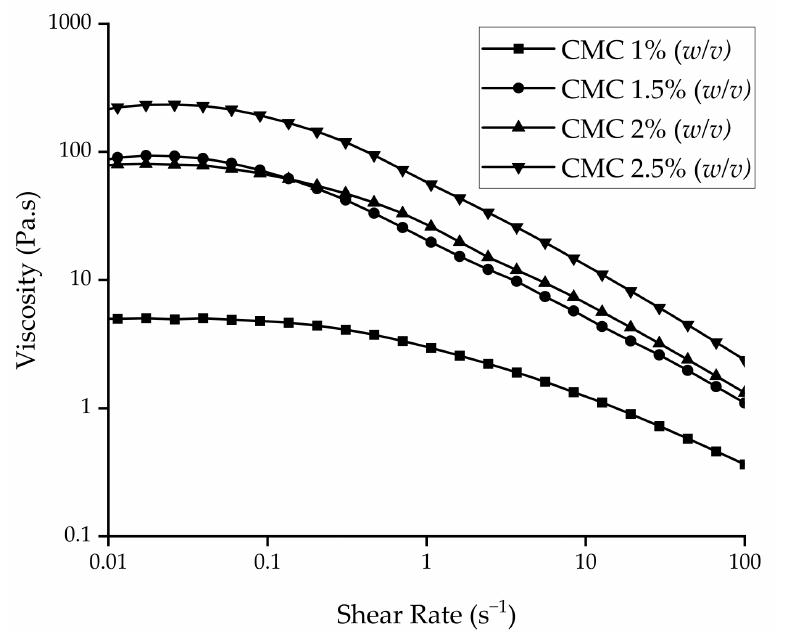
Figure 2. Rheology profiles of various concentrations of CMC